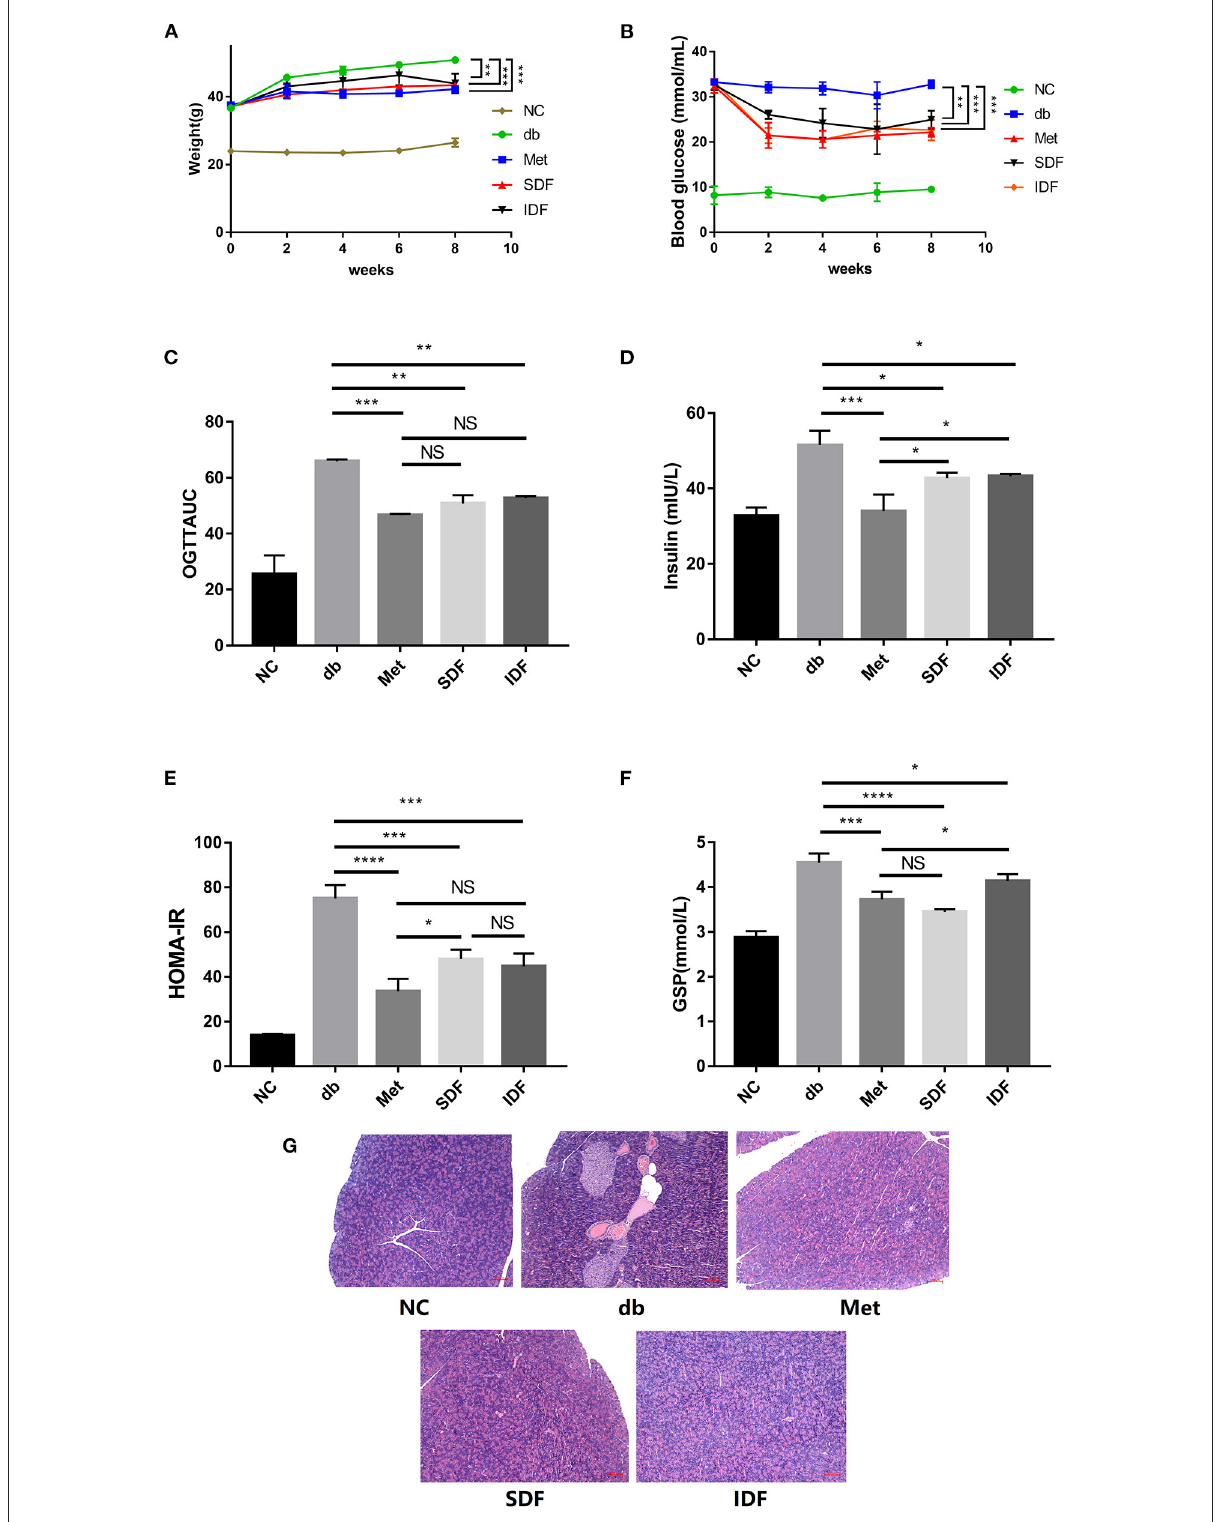
FIGURE4 DF relieves glucose intolerance in db/db mice. The (A) BW, (B) blood glucose, and (C) OGTT results of mice. (D) Insulin concentration changes were recorded at the indicated times. (E) The HOMA-IR scores of the mice were calculated at the end of the study. (F) The level of GSP was determined. (G) Microscopic images of pancreas sections. Pancreas sections were stained by H&E. Bar = 100 µ m. Each value represents the mean ± SD. The results were analyzed via the one-way ANOVA with a Tukey post-hoc test; * p < 0.05, ** p < 0.01, *** p < 0.001, **** p < 0.0001, NS,